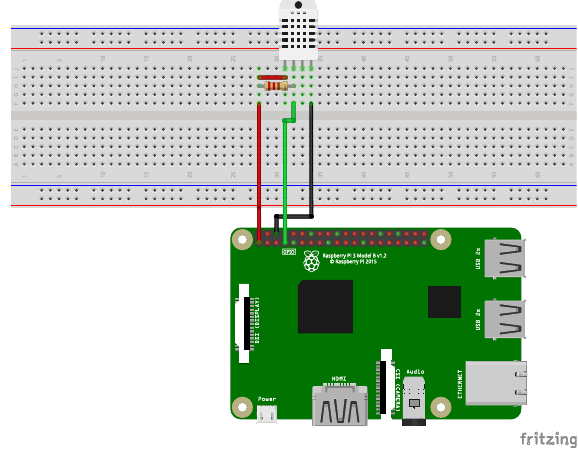
Figure 6. DHT22 Sensor connection diagram.